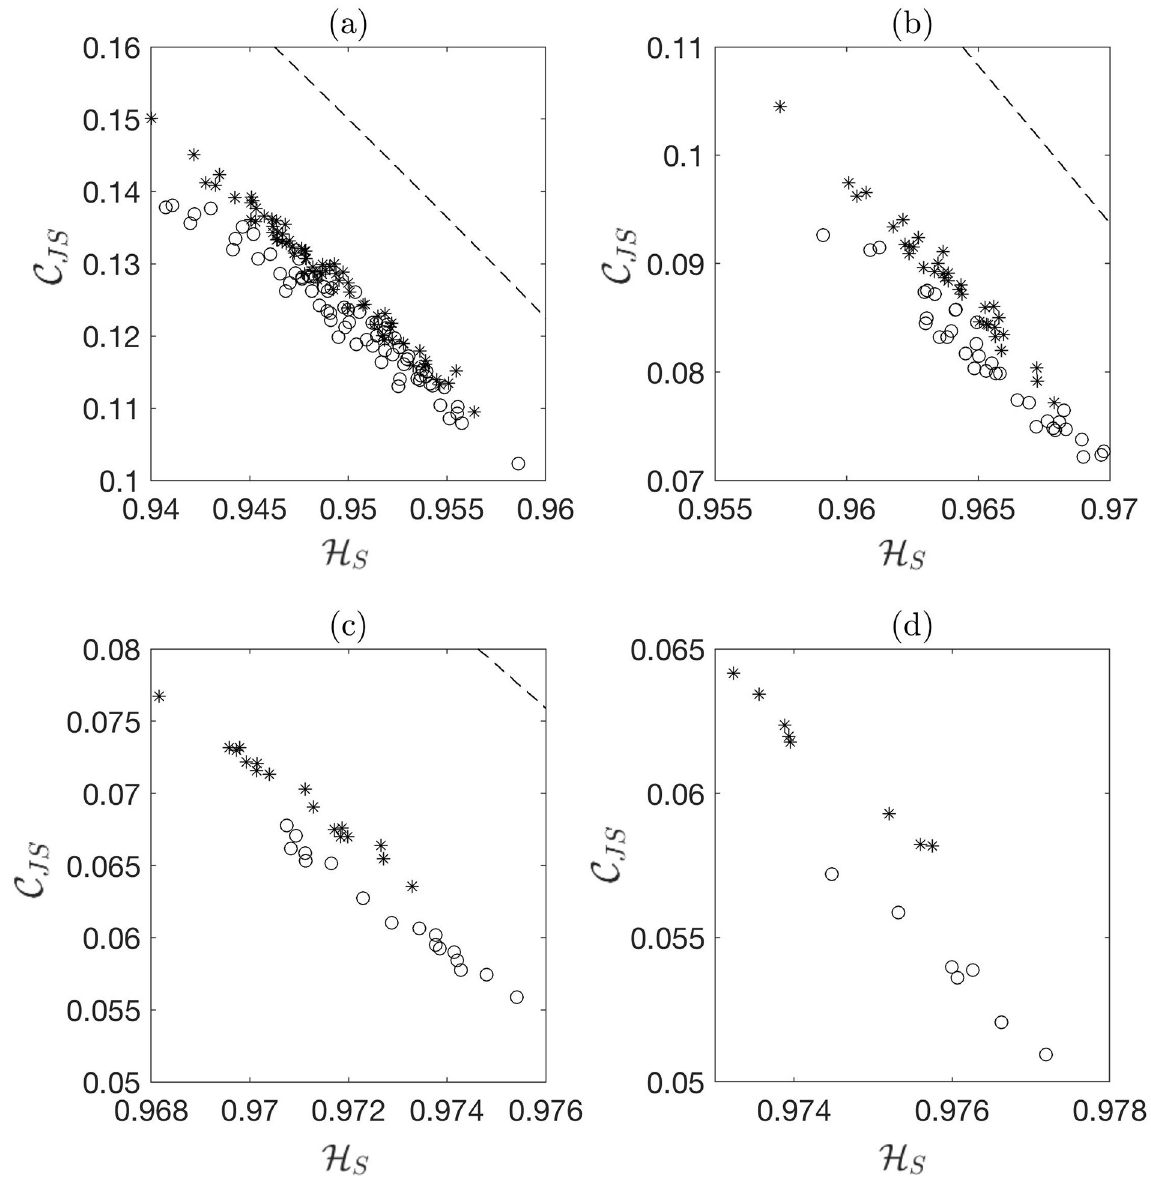
Fig 3. Complexity C vs. Permutation Entropy H feature plane for different values of subsample length N for the case of 45.35 kg (100 lb) JS S load and 25 rps (1500 rpm) rotational speed: (a) N = 2048, (b) N = 4096, (c) N = 8192, and (d) N = 16384; the CECP parameters are set to D = 6 and τ = 1. The stars represent the inner race fault and the circles represent outer race fault. The dashed lines represent the lower and upper limit curves. Some figures may not show the limit curves due to axis scale effects.